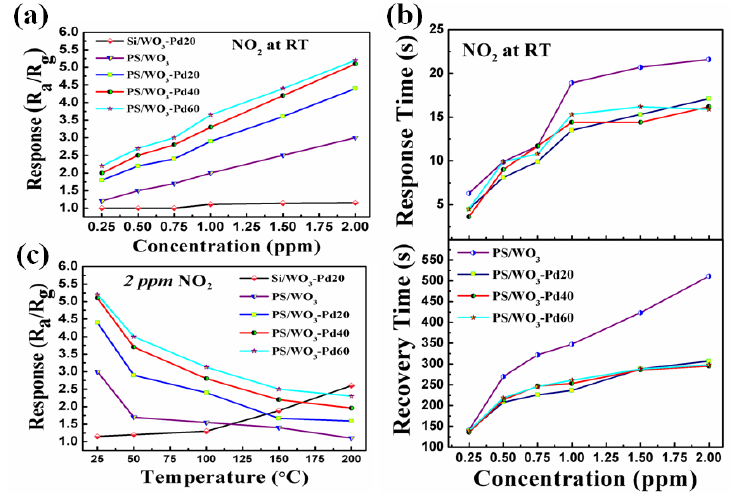
Table 1. Comparisons of NO 2 concentration, response, and working temperature of the PS/WO 3